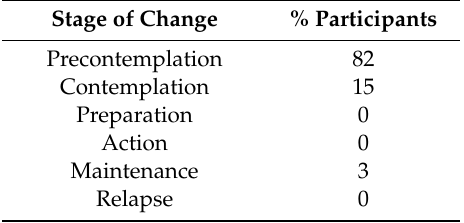
Table 3. Percentage of participants reporting each stage of change (wide-brimmed